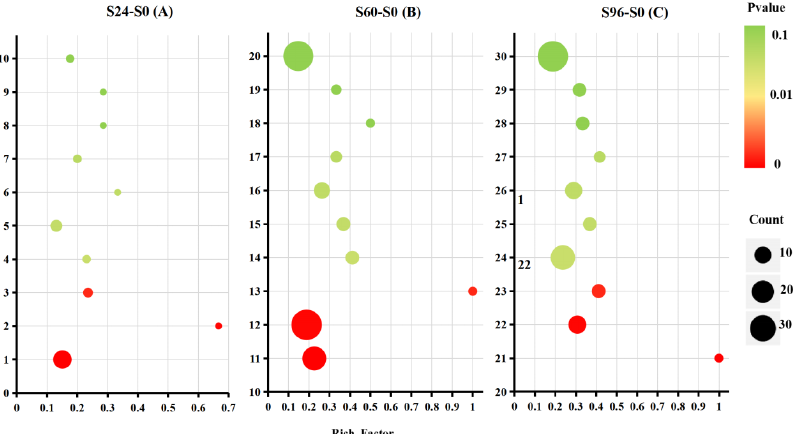
Figure 6. Bubble diagrams of the first 10 enriched KEGG pathways in S24–S0 ( A ), S60–S0 ( B ), and S96–S0 ( C ). Different numbers on the Y axis represent the following KEGG pathways: 1, RNA transport; 2, alpha-linolenic acid metabolism; 3, phenylalanine, tyrosine, and tryptophan biosynthesis; 4, valine, leucine, and isoleucine degradation; 5, mRNA surveillance; 6, ABC transporters; 7, pentose and glucuronate interconversions; 8, ether lipid metabolism; 9, nitrogen metabolism; 10, steroid biosynthesis; 11, RNA transport; 12, ribosome; 13, alpha-linolenic acid metabolism; 14, phenylalanine, tyrosine, and tryptophan biosynthesis; 15, fatty acid degradation; 16, peroxisome; 17, lysine degradation; 18, ABC transporters; 19, lysine biosynthesis; 20, biosynthesis of antibiotics; 21, alpha-linolenic acid metabolism 22, pyruvate metabolism; 23, phenylalanine, tyrosine, and tryptophan biosynthesis; 24, RNA transport; 25, fatty acid degradation; 26, peroxisome; 27, lysine biosynthesis; 28, SNARE interactions in vesicular transport; 29, fatty acid metabolism; and 30, ribosome. The rich factor represents the ratio between the DEPs and all annotated proteins enriched in the pathway. The rich factor refers to the ratio of the number of differentially expressed proteins located in the go entry to the total number of transcripts located in the go entry in all annotated proteins. The greater the rich factor, the higher the degree of enrichment. The bubble scale represents the number of DEPs, and the depth of the bubble color represents the adjusted p value.